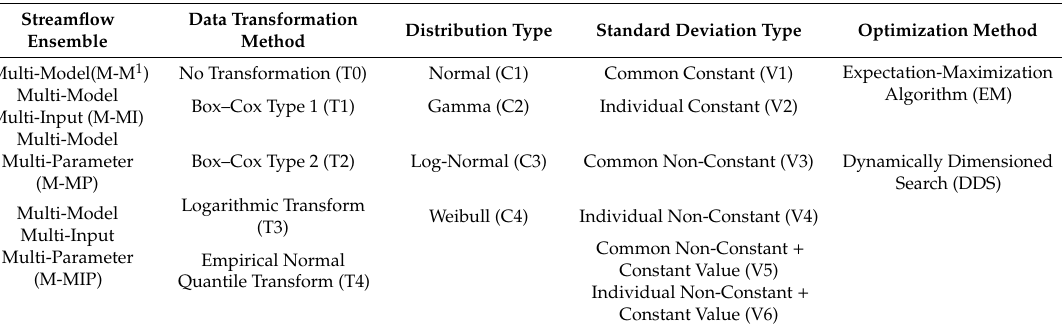
Table 1. The BMA scenario-based